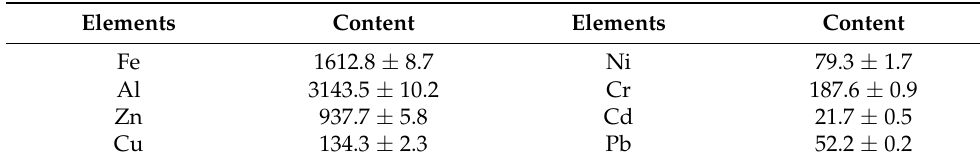
Table 2. Contents of main elements in surplus sludge mg/kg dried basis.